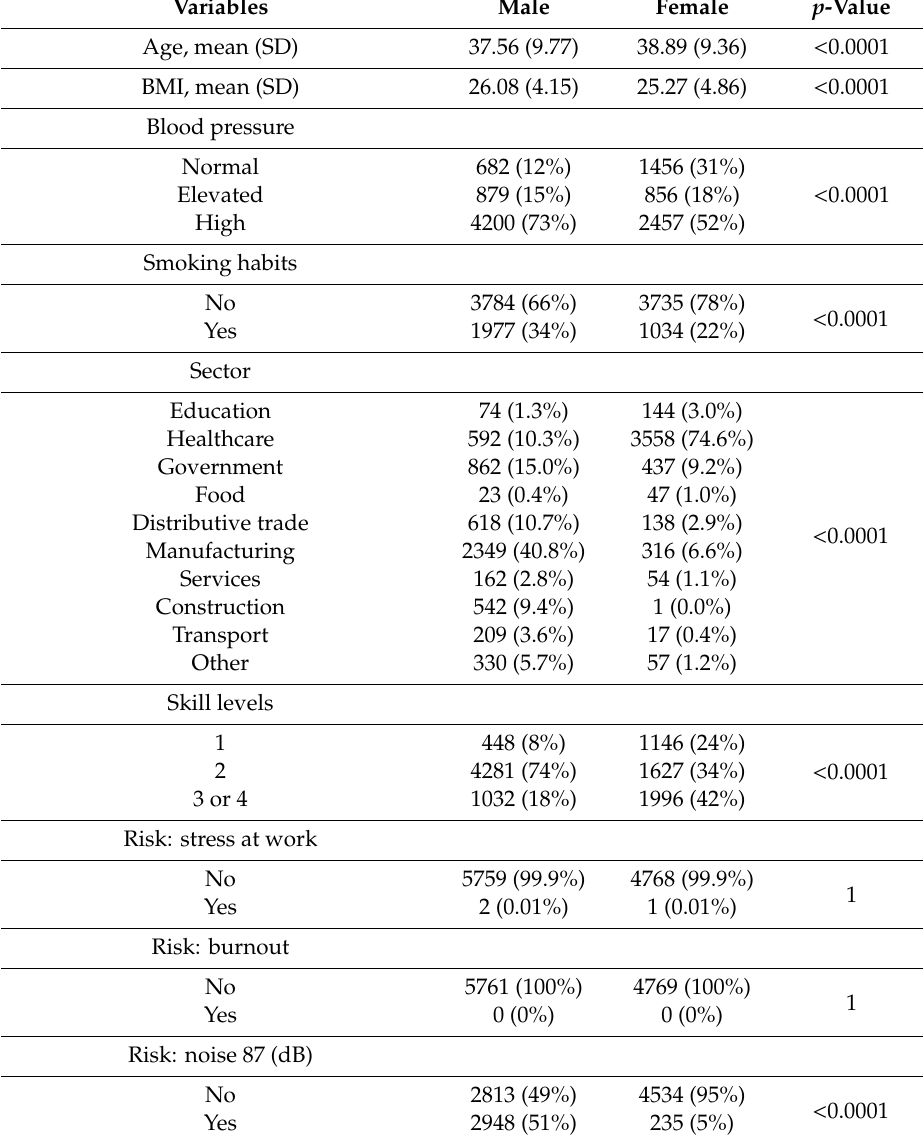
Table 1. Baseline characteristics 10530 Belgian workers by